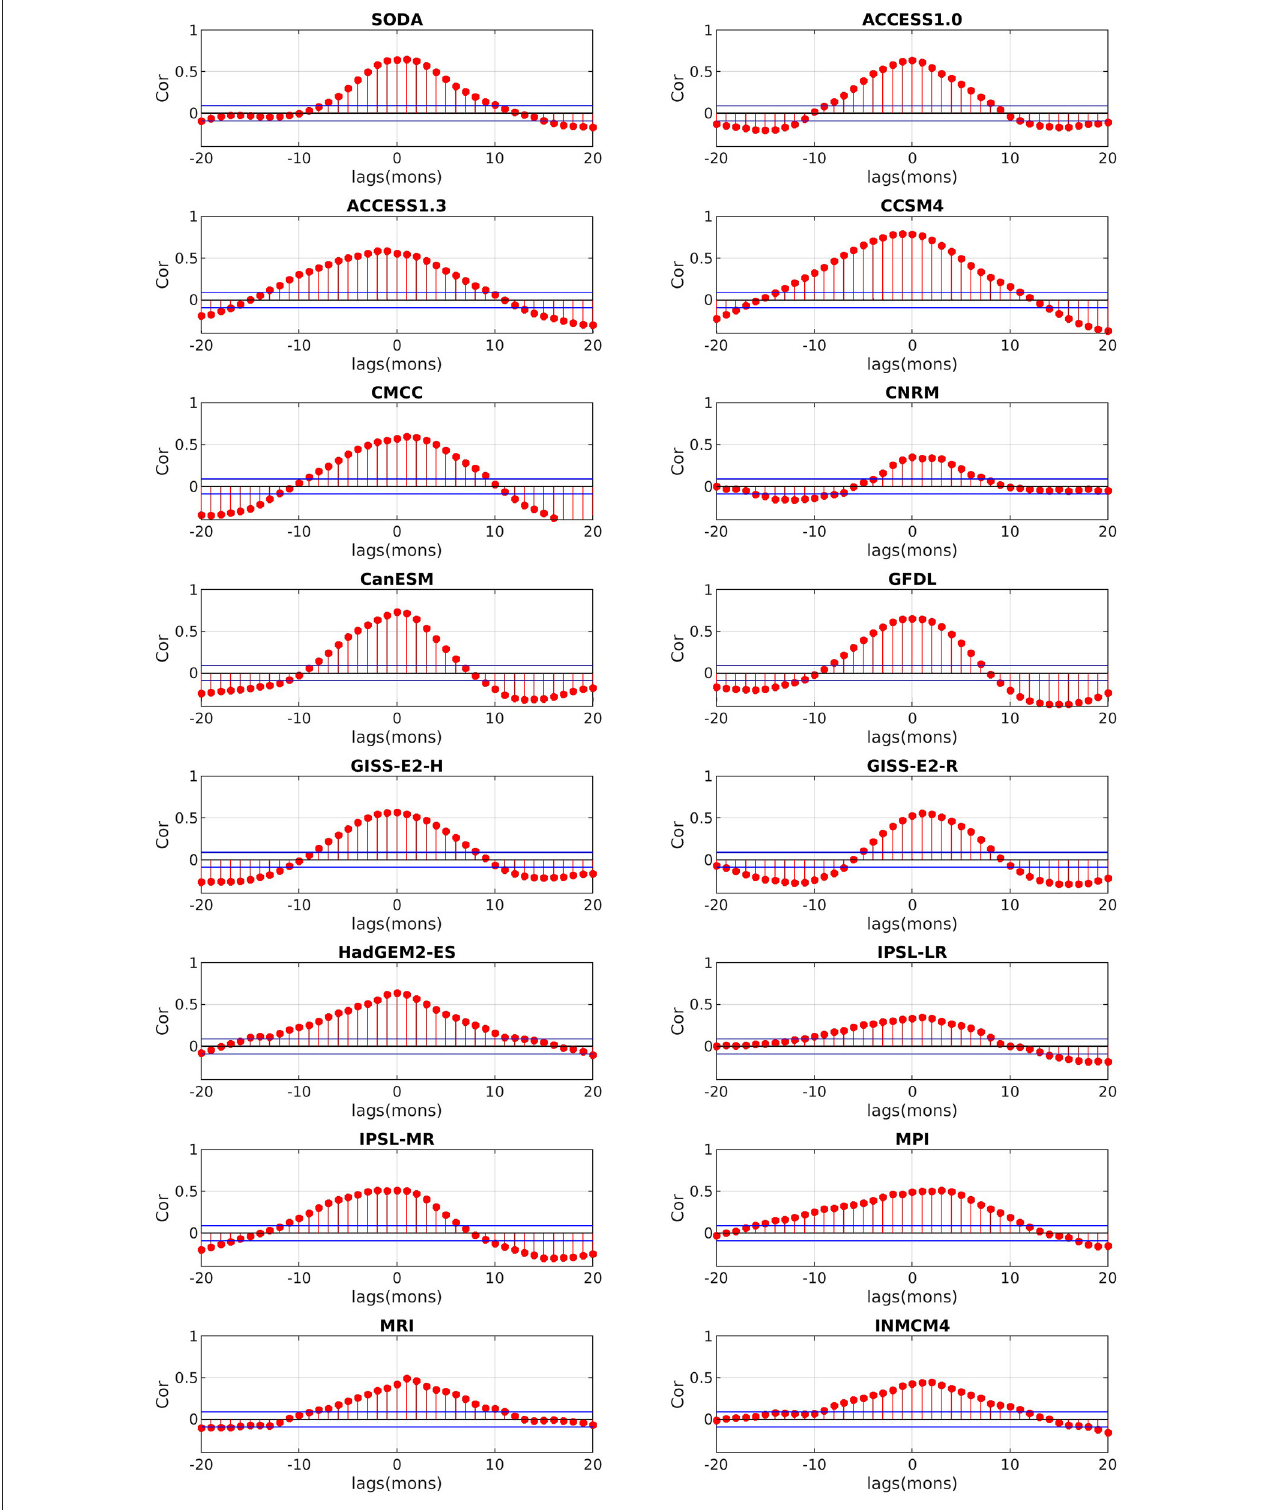
FIGURE 9 | Cross correlation between the sea level pressure anomalies (SLPAs) over the SETIO region and the Niño3.4 Index during 1967–2005 for models and during 1980–2018 for SODA/ERA-interim reanalysis. Positive (negative) lags indicate SLPa lags (leads) the Niño3.4 Index.